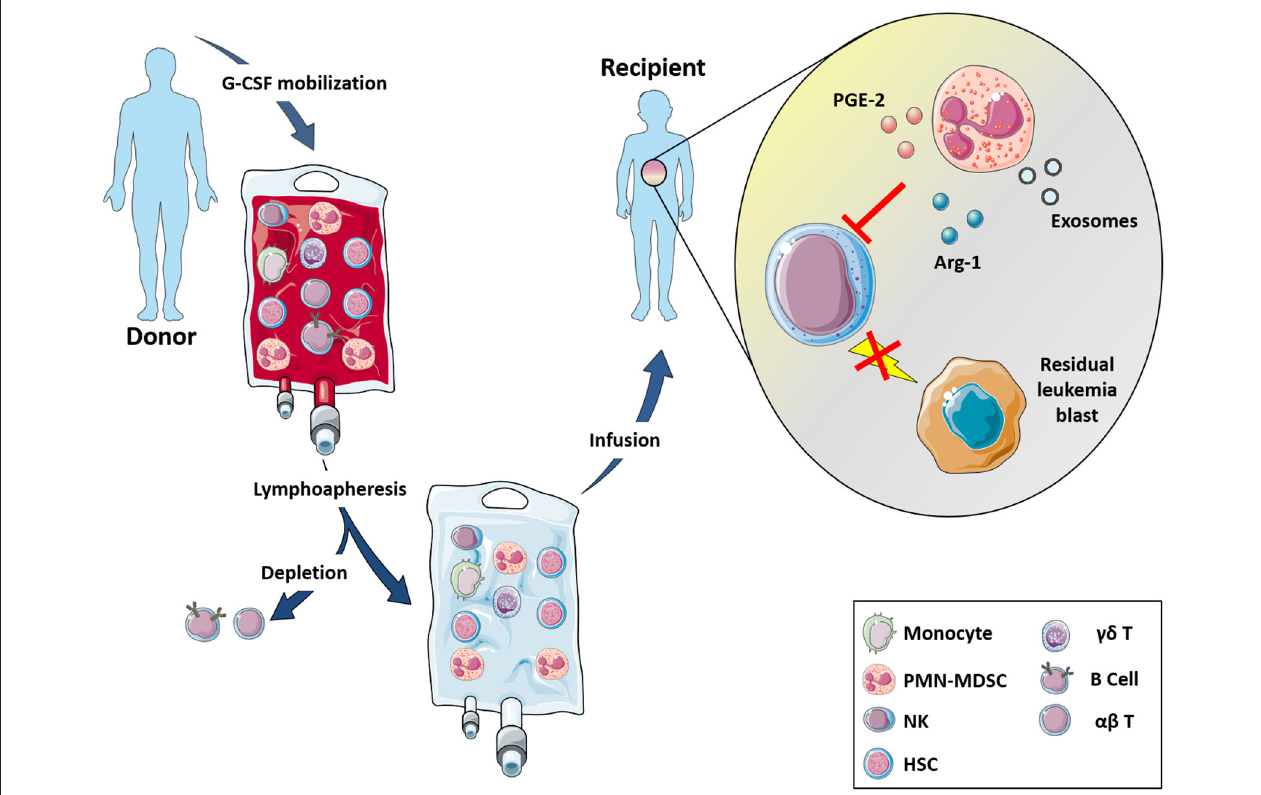
FIGURE 1 | αβ T- and B-depleted hematopoietic stem cell transplantation protocol. Donors undergo lymphoapheresis after 5 days G-CSF stimulation for increasing the number of HSC cells and to induce PMN-MDSC mobilization. Thus, αβ T and B cells are depleted and infusion (enriched in NK cells, γδ T-cells and myeloid cells) is administered to recipient patients. In this transplant setting, the enrichment of PMN-MDSC helps to reduce NK cell cytotoxic effects against the graft by the release of IDO2, PGE2, and exosomes thus suggesting a possible involvement of these myeloid cells into the GvL activity mediated by NK cells.